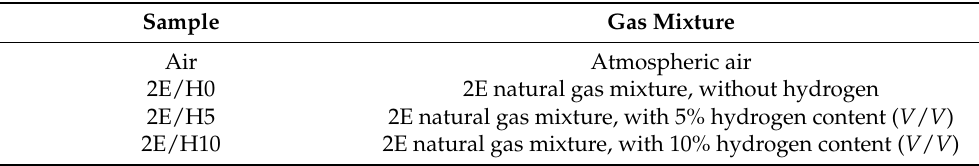
Table 2. Characteristics of the gas mixtures used for the metrological tests.